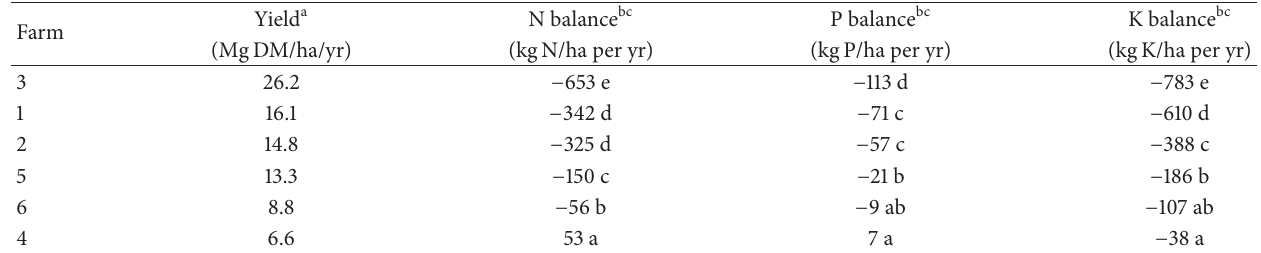
Table 6: Brachiaria cv. Mulato II dry matter yield and N, P, and K balances by farm. Yield a N balance bc P balance bc K balance Farm